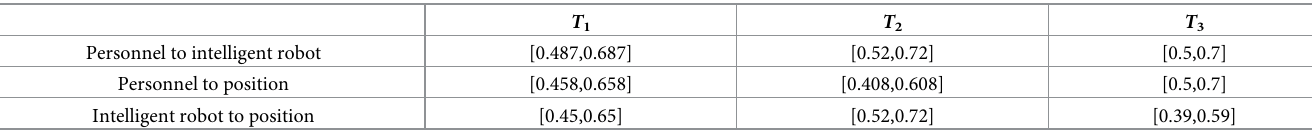
Table 4. Initial reference points of each